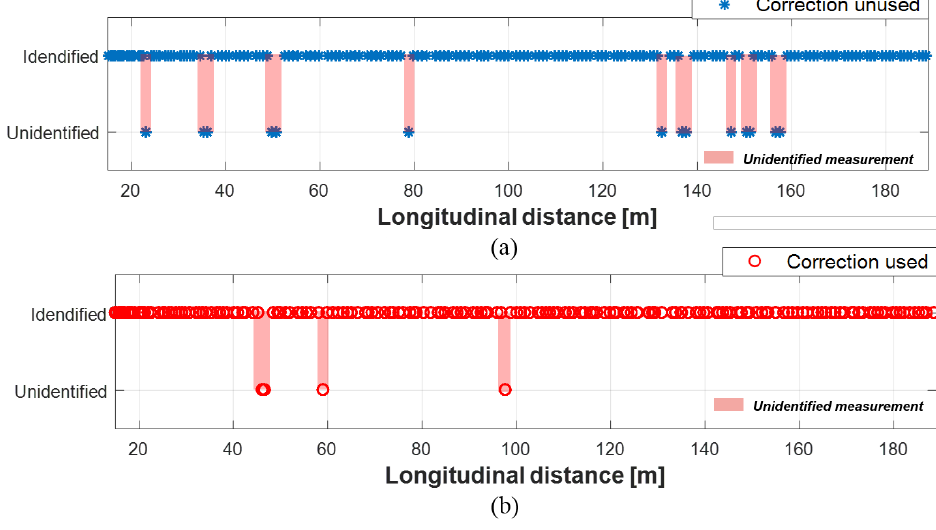
Figure 16. Object identification status of radar: ( a ) Without correction. ( b ) With